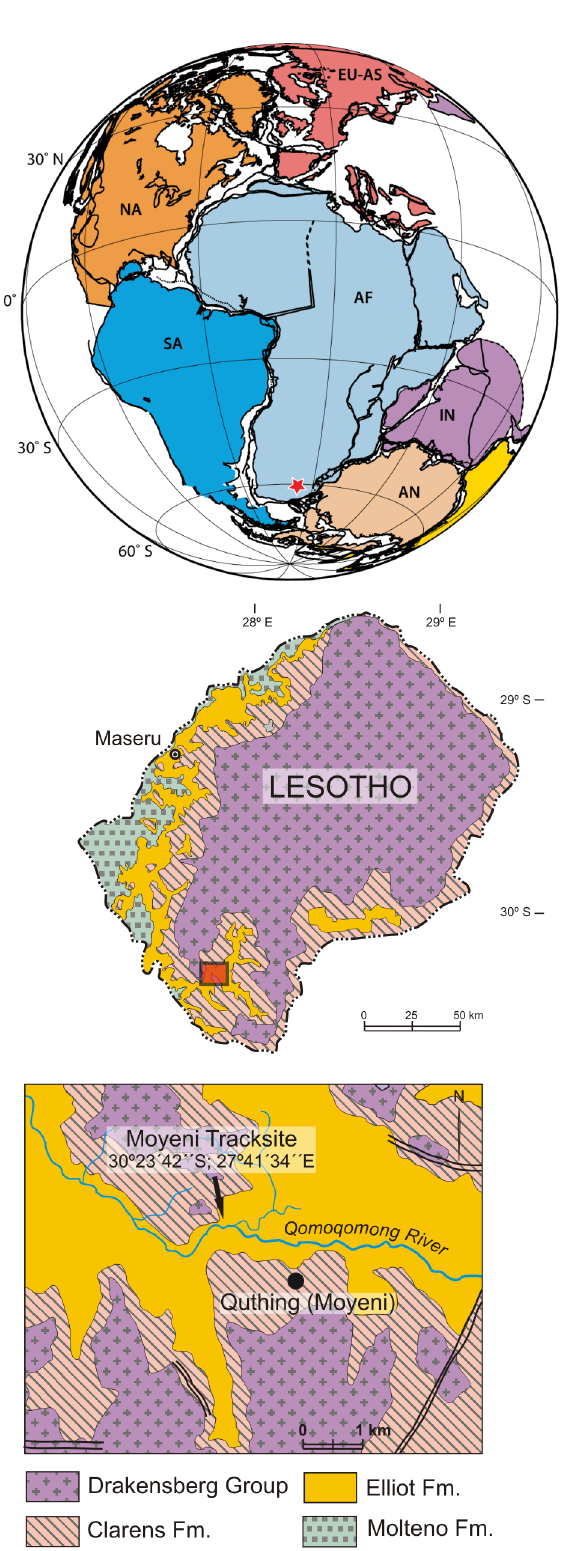
Figure 1. Location of Moyeni tracksite, Lesotho. Top, paleogeo- graphic reconstruction of southern Pangea during the Late Triassic, 200 Ma (map produced at the University of Texas Institute for Geophysics, 2012; http://www.ig.utexas.edu/research/projects/plates/). Locality is indicated by a star. Bottom, Google Earth image of southern Lesotho showing location of Moyeni tracksite (building indicated by